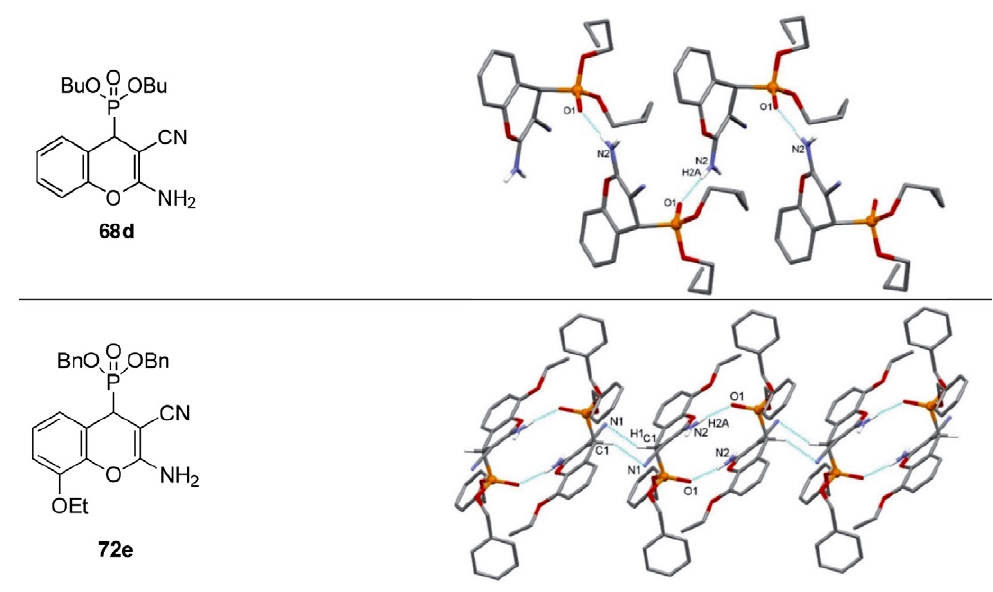
Figure 5. The crystal structure of 68d and 72e (2-amino-3-cyano-4 H